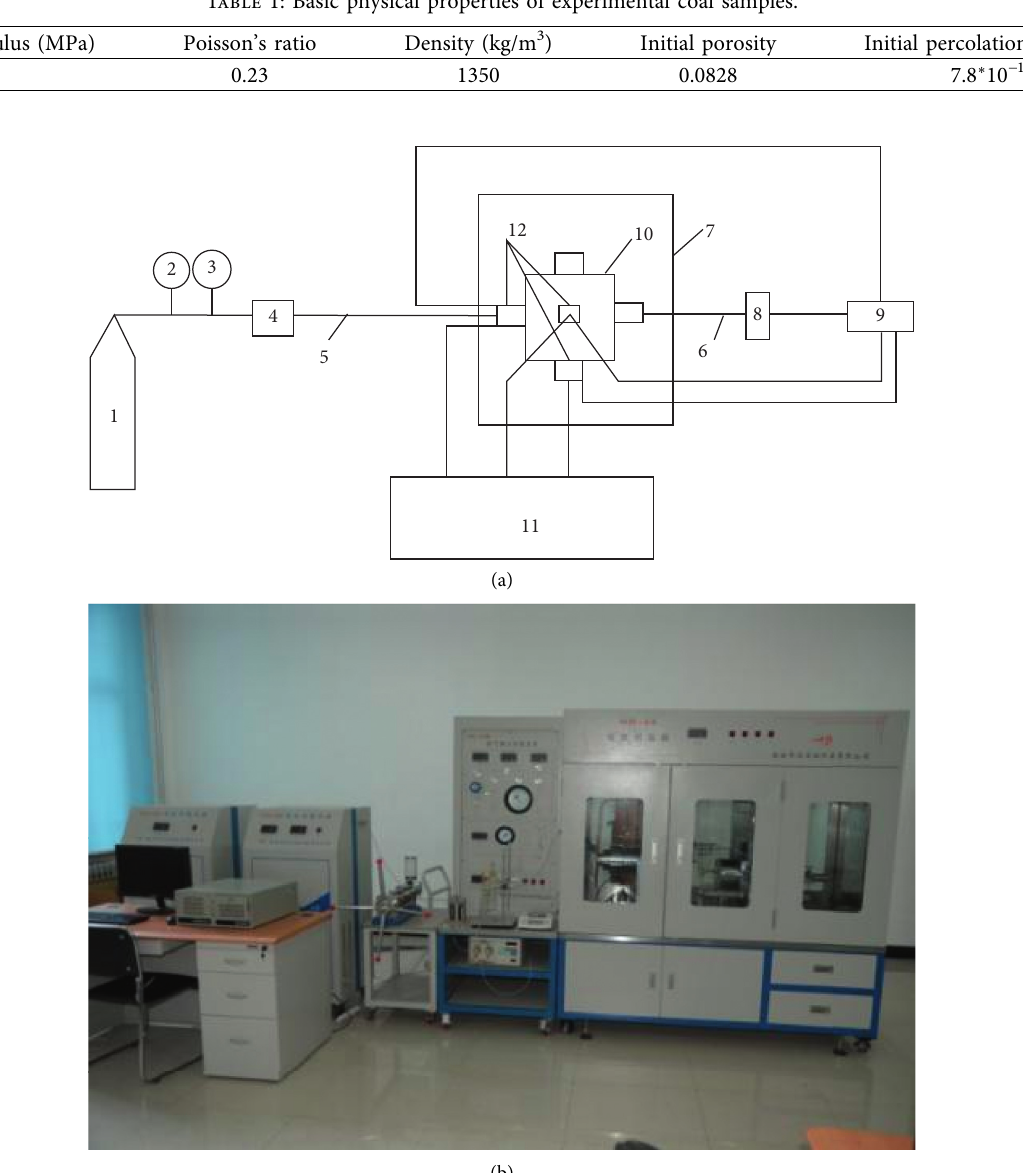
Figure 2: Thermos-solid-gas coupling equipment testing program. (a) Principle structure chart of the device. (1) Voltage gas supply source; (2) manometer; (3) pressure control valve; (4) pressure supply system; (5) intake gassing pipeline; (6) out gassing pipeline; (7) constant- temperature test chamber; (8) flow surveillance system; (9) data acquisition and operating system; (10) true triaxial fixture; (11) servo pump; (12) stress-strain and temperature sensor. (b) Experimental